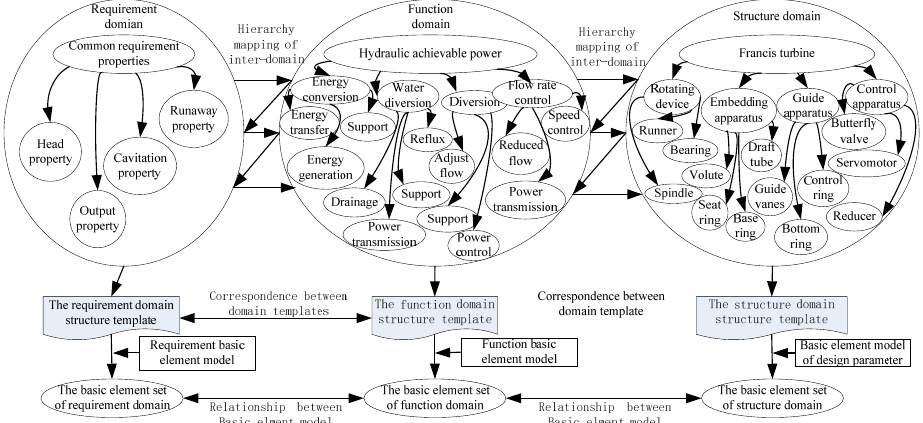
Figure 3. The framework of the Francis turbine’s common design requirements information template.